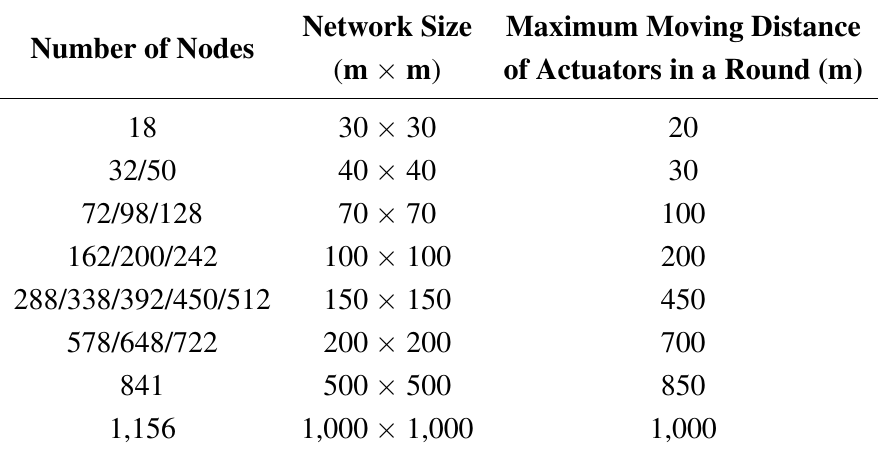
Table 2. Simulation parameters of different network